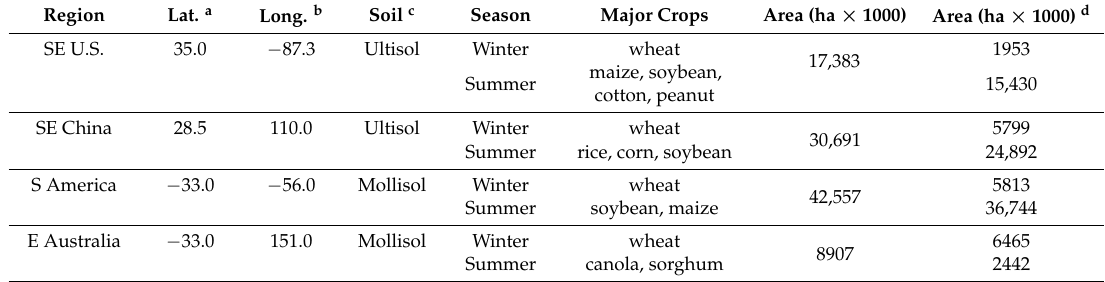
Table 1. Reference locations and main characteristics for the main humid subtropical regions of the world. Region Lat. a Long. b Soil c Season Major Crops Area (ha × 1000) Area (ha × 1000) d SE U.S. 35.0 − 87.3 Ultisol Winter wheat 1953 17,383 maize, soybean, 15,430 Summer cotton, peanut 28.5 110.0 − 33.0 − 56.0 − 33.0 151.0 Mollisol Winter wheat canola, sorghum